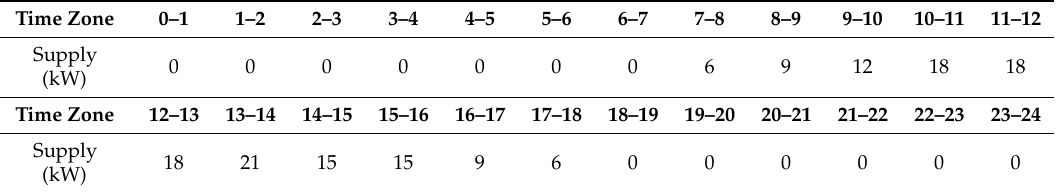
Table 5. Forecast prices of power supply schedule (virtual data) (kW).